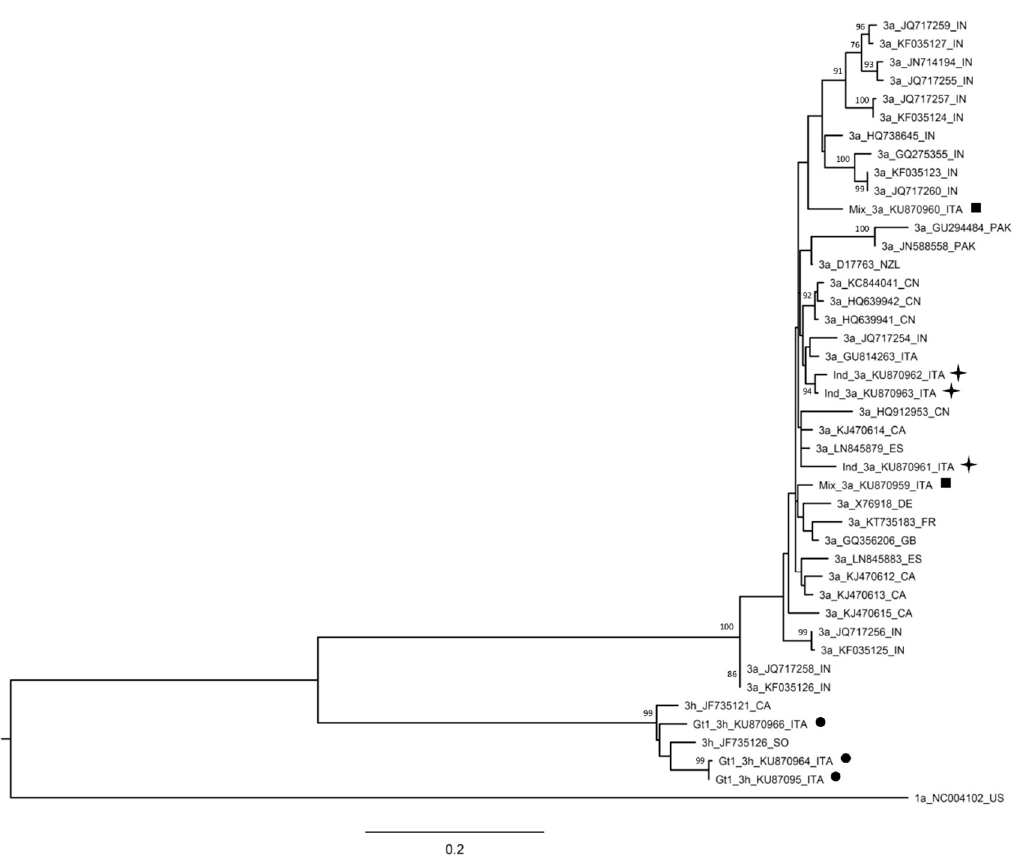
Figure 2. NS5B phylogenetic tree of genotype 3 samples. Bootstrap analysis with 500 replicates is performed to assess the significance of the nodes; values greater than 70% are considered significant and reported in the figure. A genotype 1a sequence (1a_NC004102_US) is used as the outgroup. Sequences from patients resulted genotype 1, mixed infection or indeterminate by Abbott RealTime HCV Genotype II assay are indicated with a circle ( ● ), a square ( ■ ), or a star ( ), respectively.